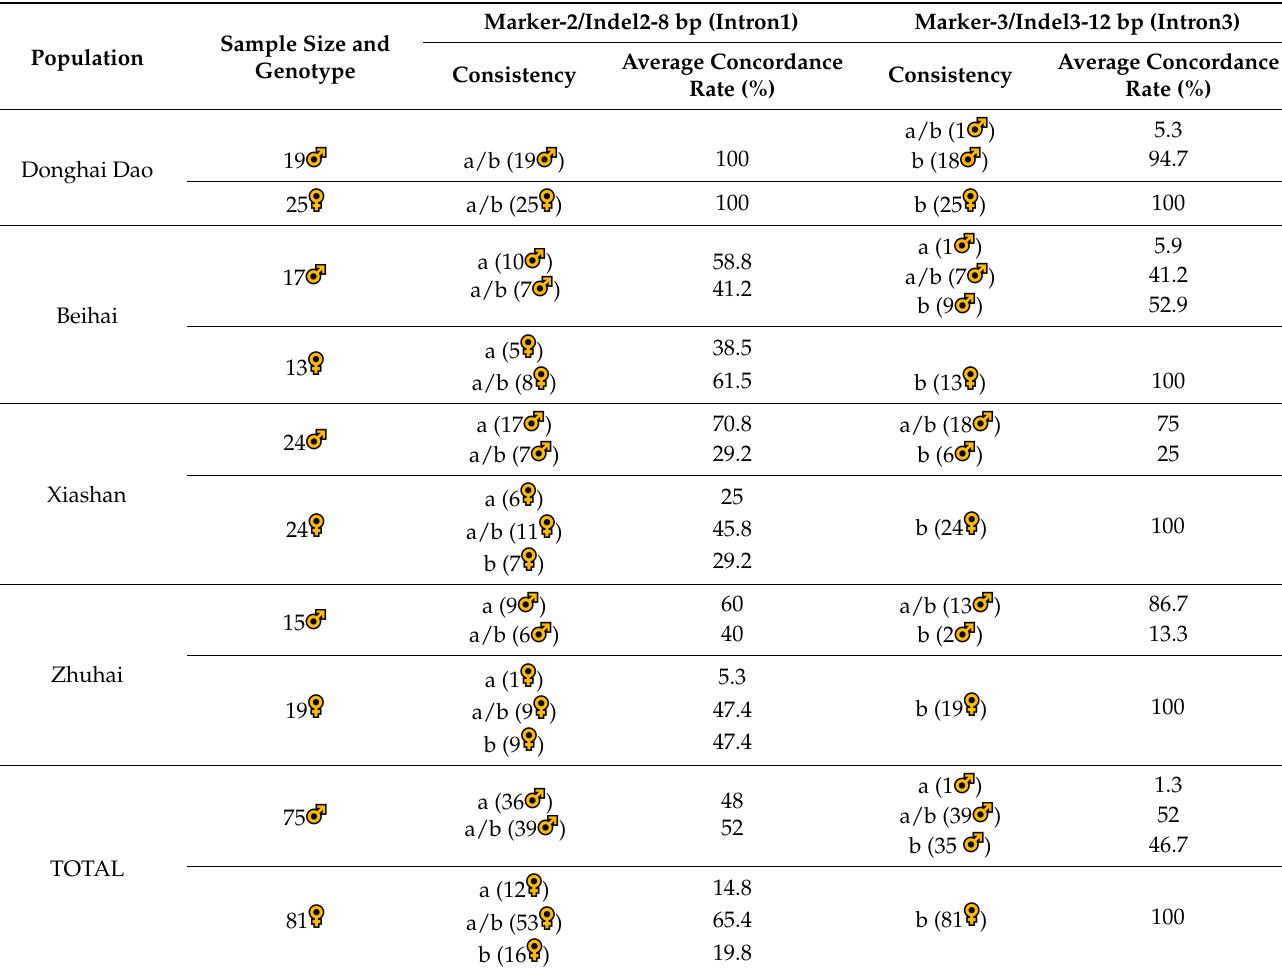
Note: For marker- 4, bands “a”, “a/b” and “b” indicate 543 bp, (453 and 444 bp) and 444 bp bands, respectively. For marker- 6, bands “a” and “a/b” indicate 158 bp, and (158 and 144 bp) bands, respectively. The “a” and “b” inscriptions are shown in Figure 4.